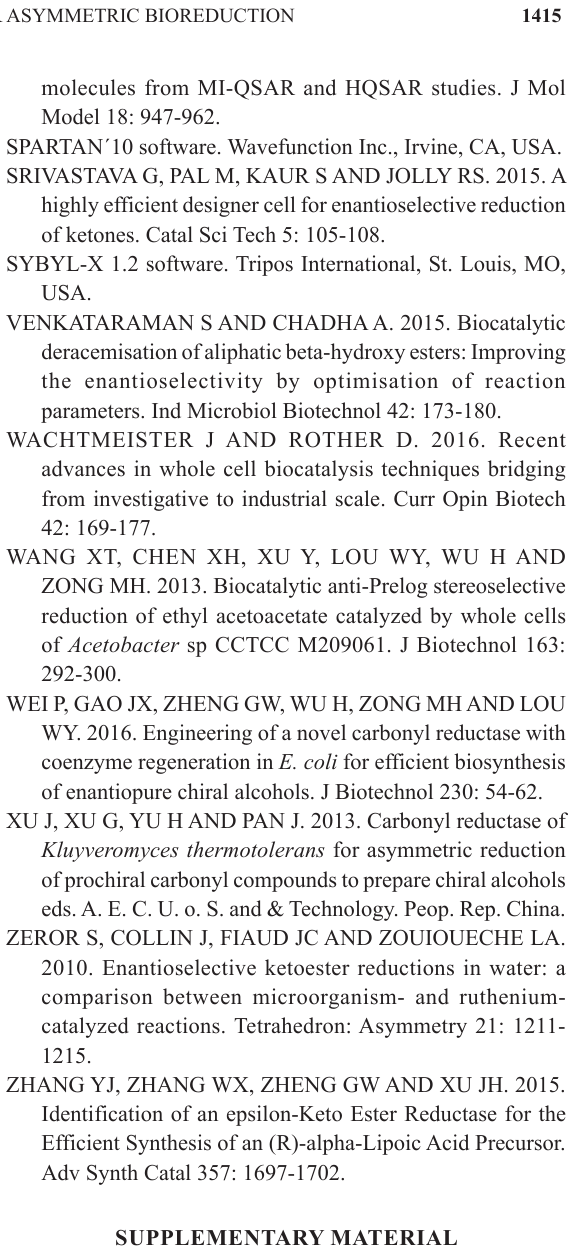
Figure S1 - Lowest Unoccupied Molecular Orbital (LUMO) electron density map on both sides of the β-ketoesters ( 1- 13 ). The electron-deficient area is shown in shades of blue ranging from pale to deep